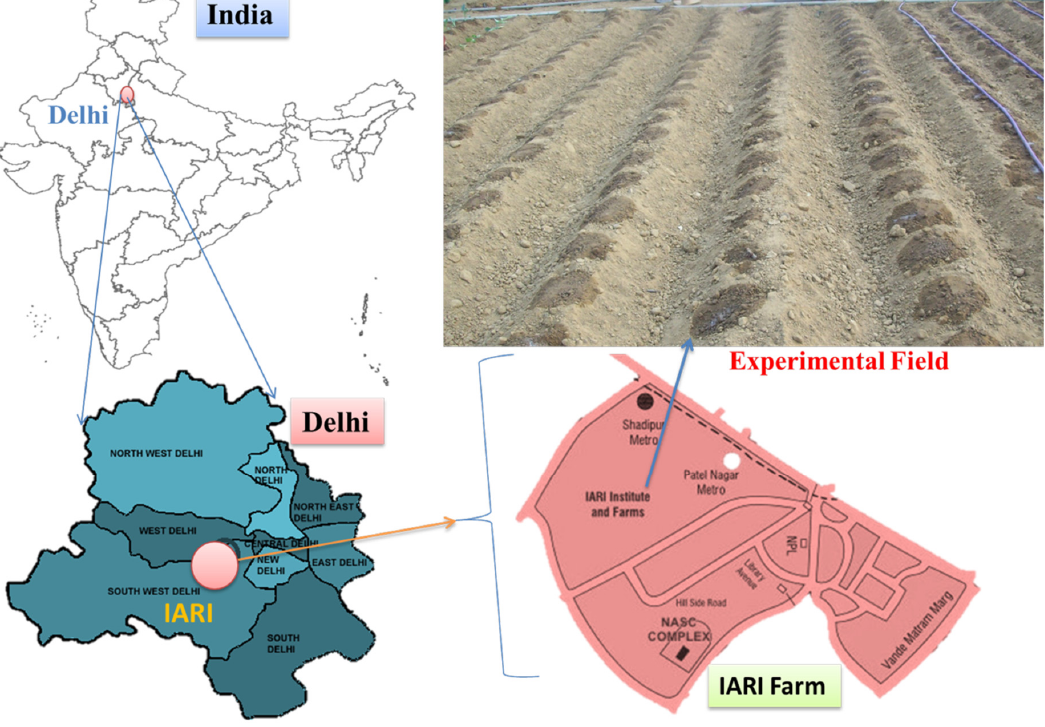
Table 1. Physical properties of soil.